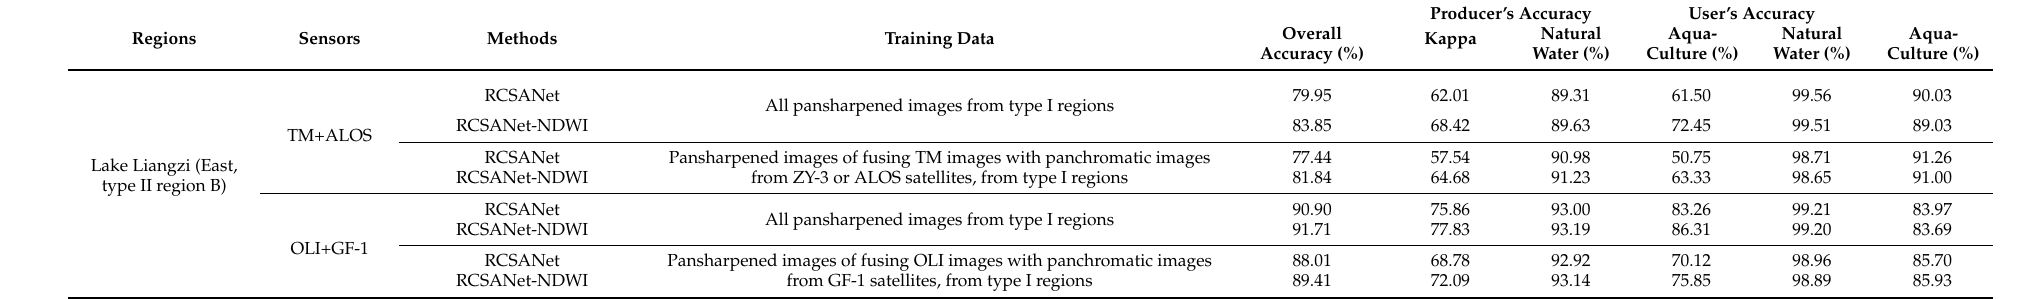
Table 5. Accuracy comparation of semantic segmentation results for region B by dividing the training data of Part 2 of the experiment into pansharpened TM images and pansharpened OLI images